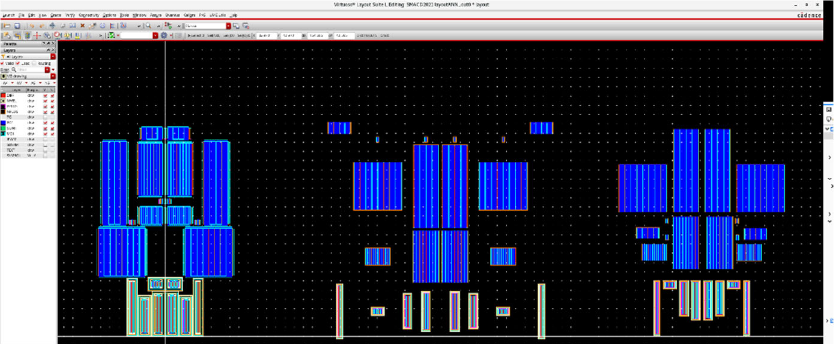
Figure 4. Placements generated by Virtuoso XL, a human designer and the proposed toolbox, along with the total, the proximity and the current ‐ flow error graphs. ( a ) Cadence generated placement. ( b ) Human designed placement. ( c ) Toolbox’s generated placement. Table 1. Floorplans’ error comparison for the current starving single ‐ stage amplifier biased by voltage ‐ combiners.